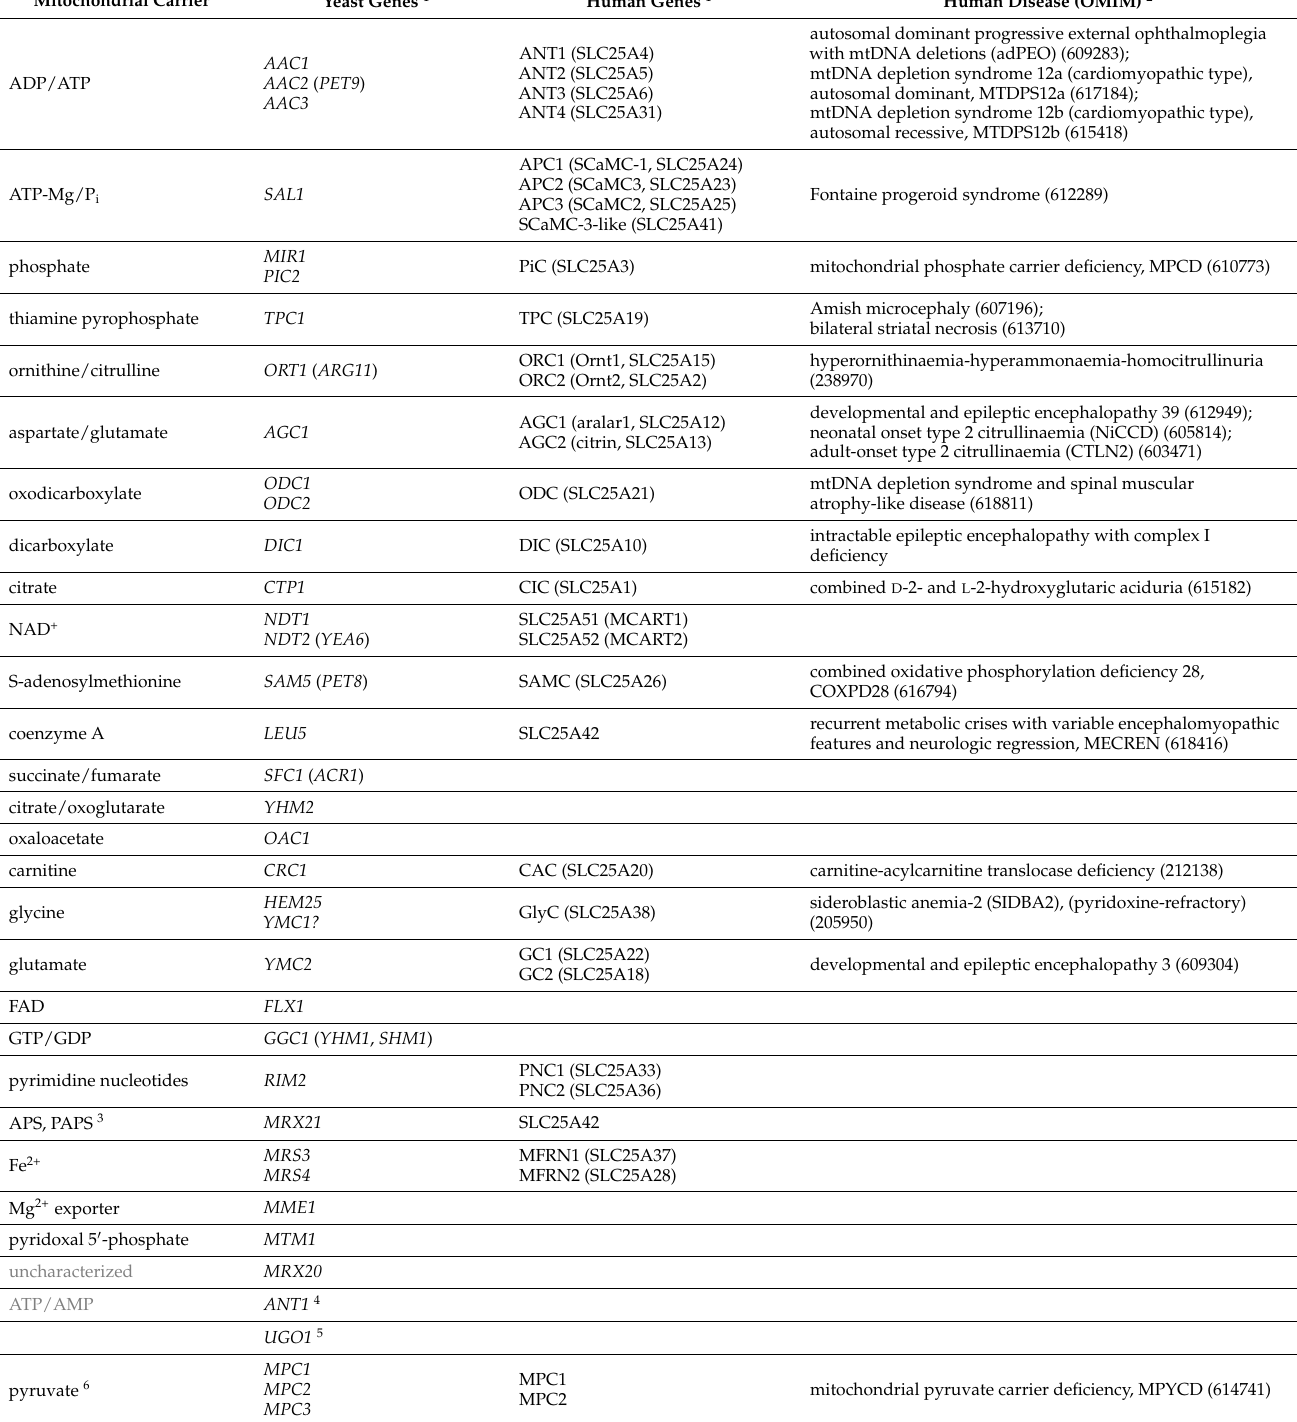
Table 1. Overview of identified yeast mitochondrial carriers, their human homologues and associated human